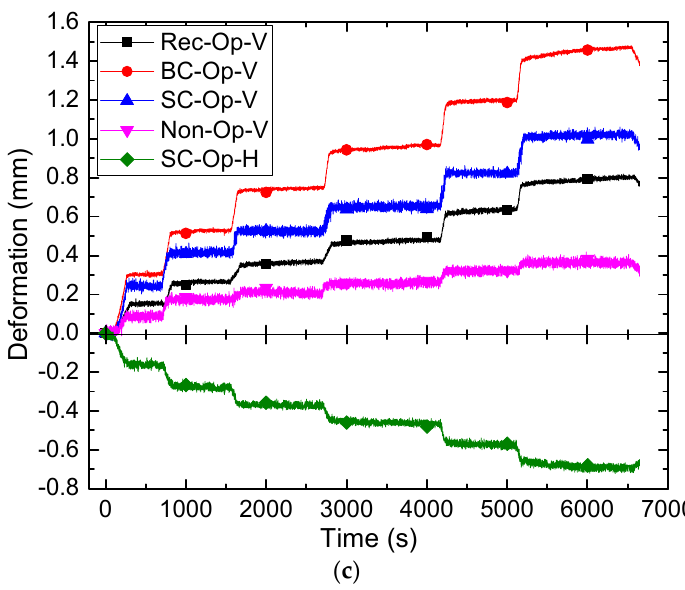
Figure 10. Variations of deformations versus test time: ( a ) 1.0 D, ( b ) 1.5 D, ( c ) 2.0 D.